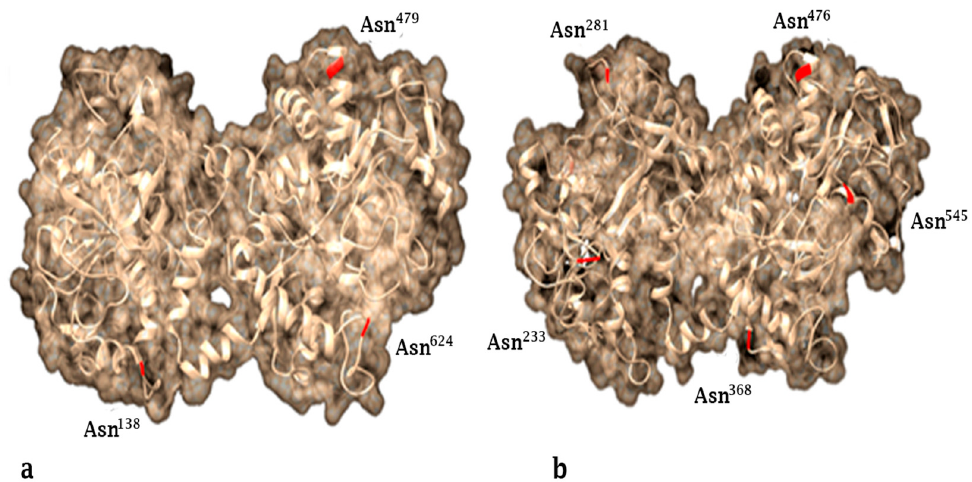
Figure 1. Predicted structure of Lactoferrin and its potential glycosylation sites (Asn n ). ( a ) Human lactoferrin. ( b ) Bovine lactoferrin. Potential asparagine-linked glycosylation sites are shown in red. The glycosylation of the molecule may be strongly involved in the mechanism of action of its various physiological processes. The protein sequence was extracted from GenBank: M83202_1 (hLf) and M63502_1 (bLf) and modeled using Phyre2 (http://www.sbg.bio.ic.ac.uk/phyre2/ [18]) .